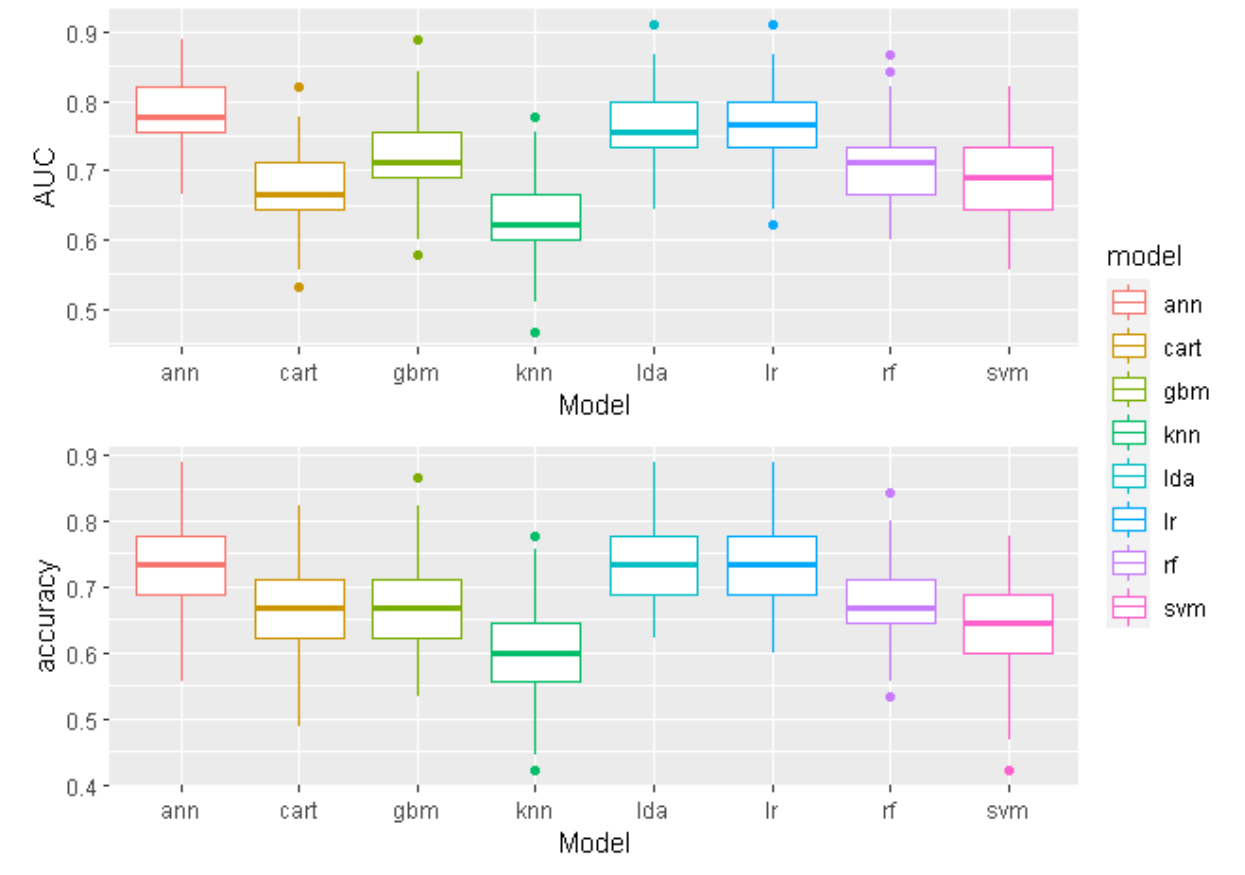
Figure 2. Comparison of AUC and accuracies for all eight models from 100 model trainings with different seed values.